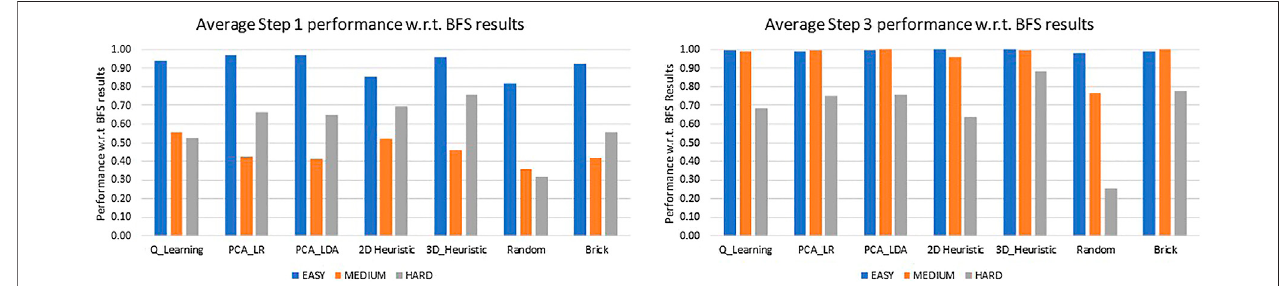
FIGURE 11 | A comparison of performance of various policies for objects categorized into easy, medium and hard, for Step 1 and Step 3 with respect to the BFS performance at those steps.